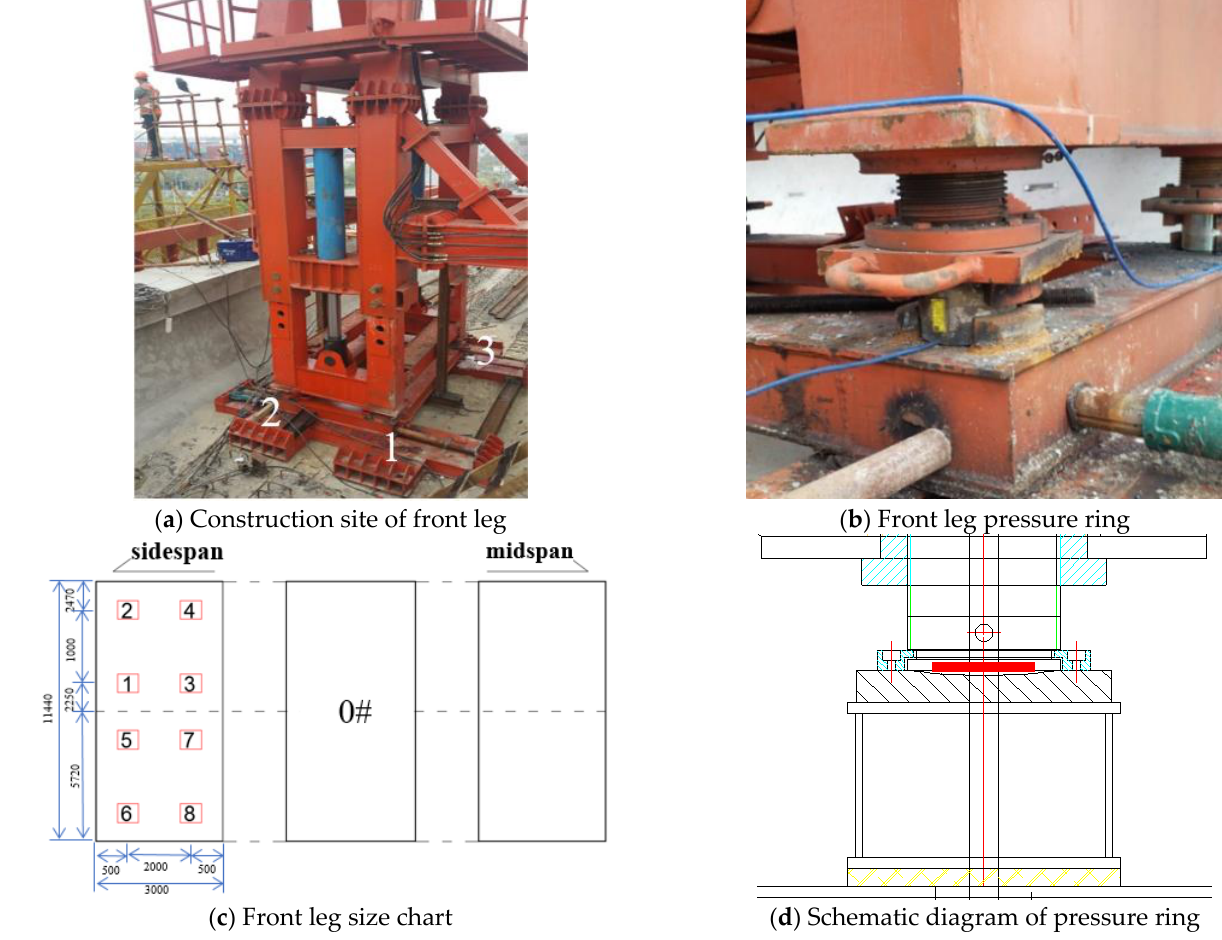
Figure 5. Schematic diagram of the pressure ring sensor.